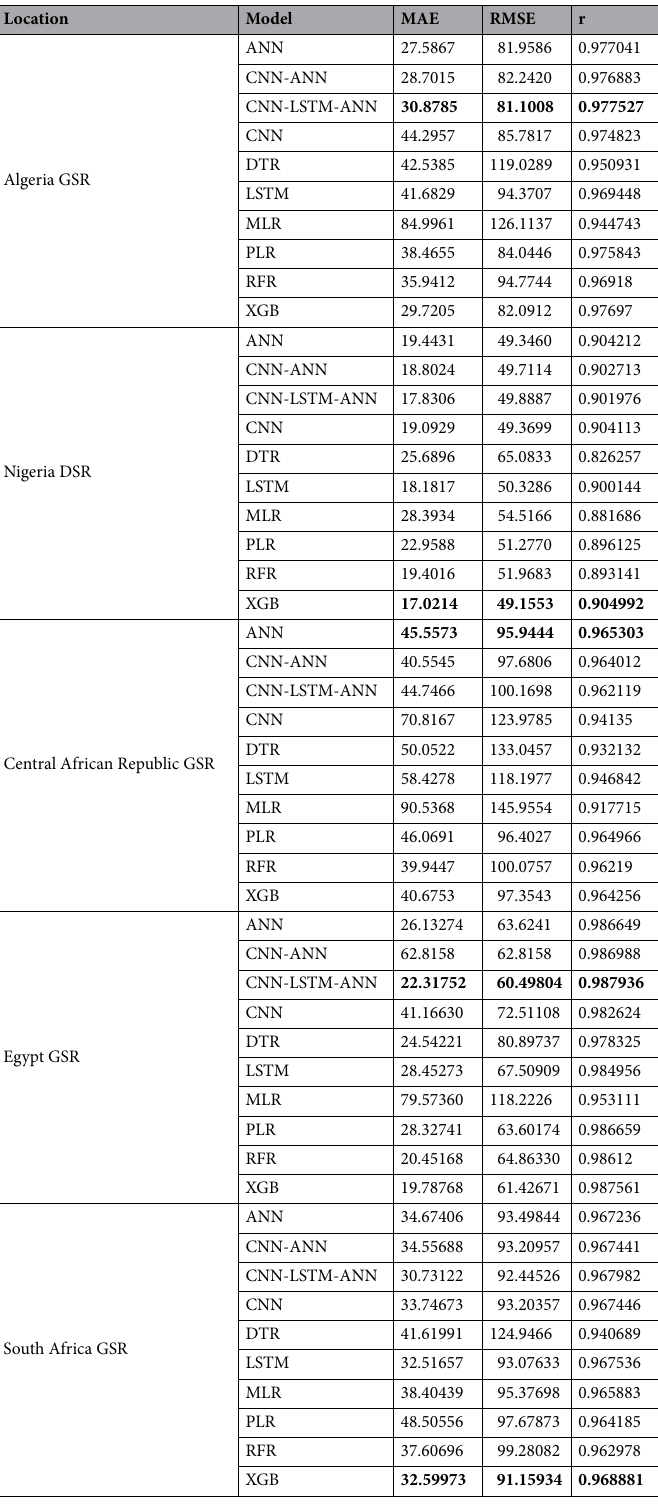
Table 7. Hourly SR task evaluation metric summary. Significant values are in